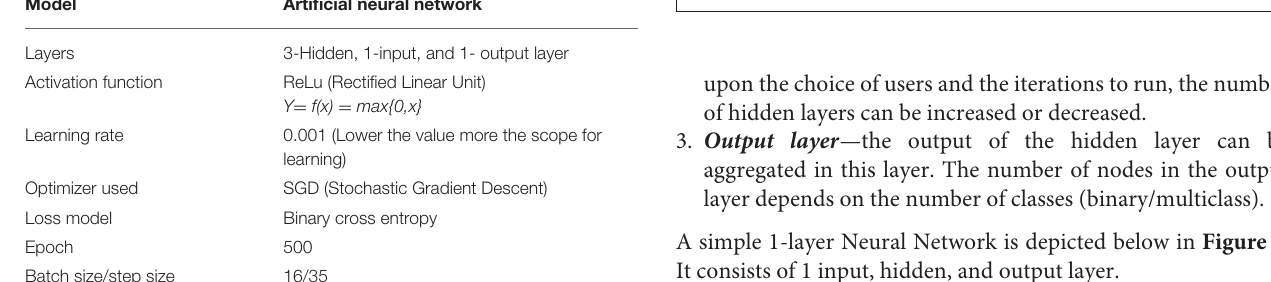
FIGURE 5 | A simple perceptron model with a 1-hidden